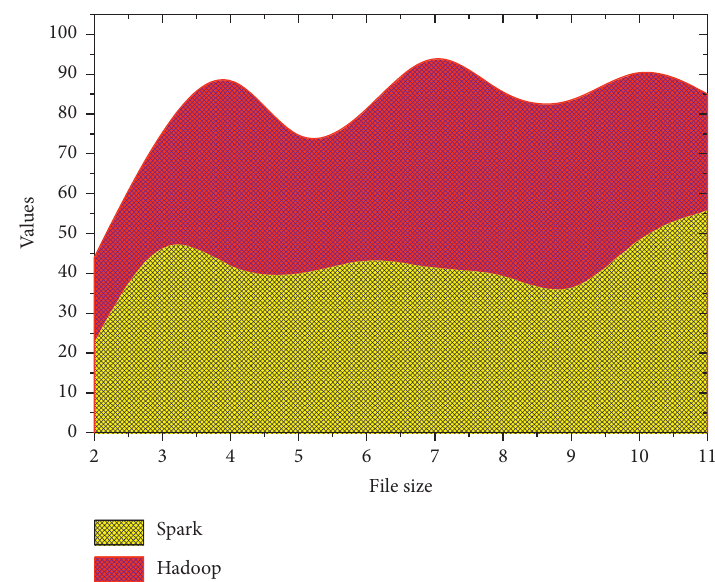
Figure 8: System deep learning runtime